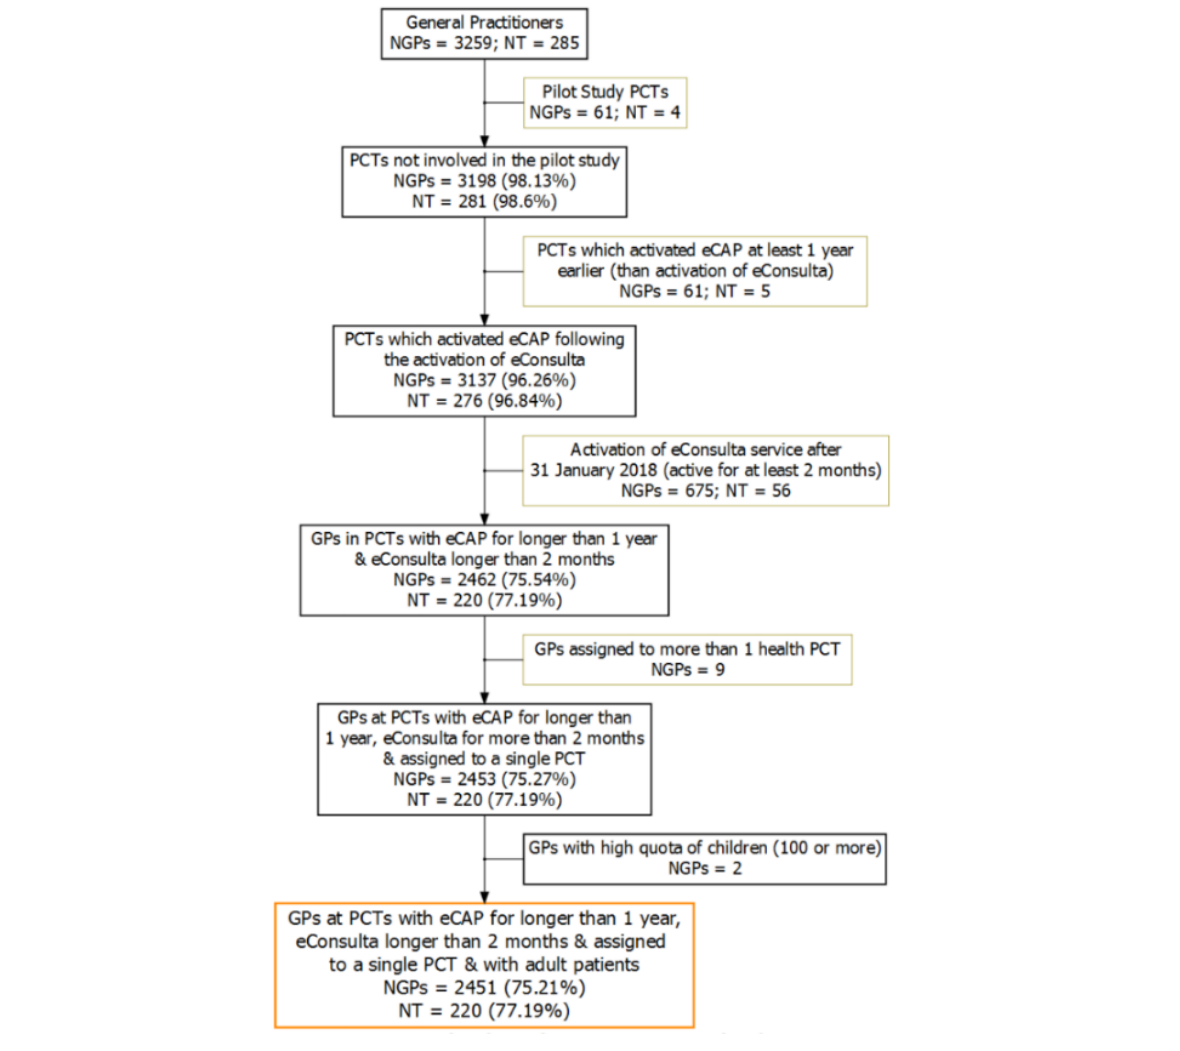
Figure 1. Flowchart of the study population. NGP: number of general practitioners; NT: number of primary health teams; PCT: primary health team; eCAP: primary care information system; GP: general practitioner.